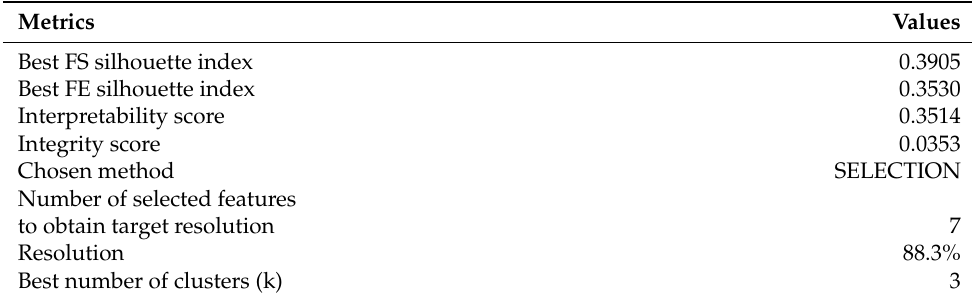
Table 5. Algorithm results using interpretability-oriented = 0.9, integrity-oriented = 0.1 and target- resolution =